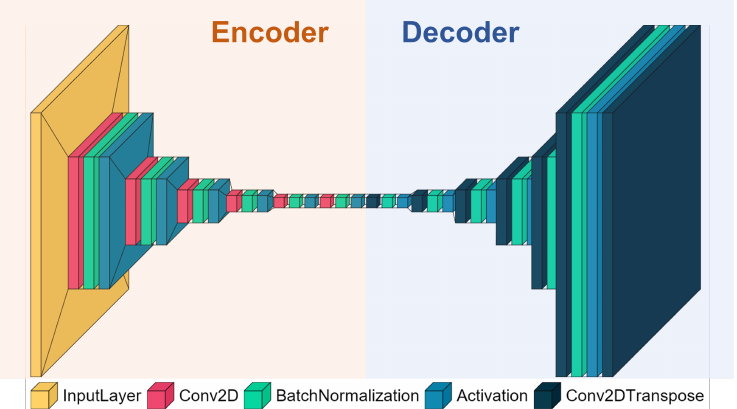
Figure 4. The structure of AE. There are two parts: encoder and decoder. A 2D convolutional (or deconvolution) layer, a batch normalization layer, and an activation layer are composed of an FCN layer. Both in the encoder and the decoder, there are 6 FCN